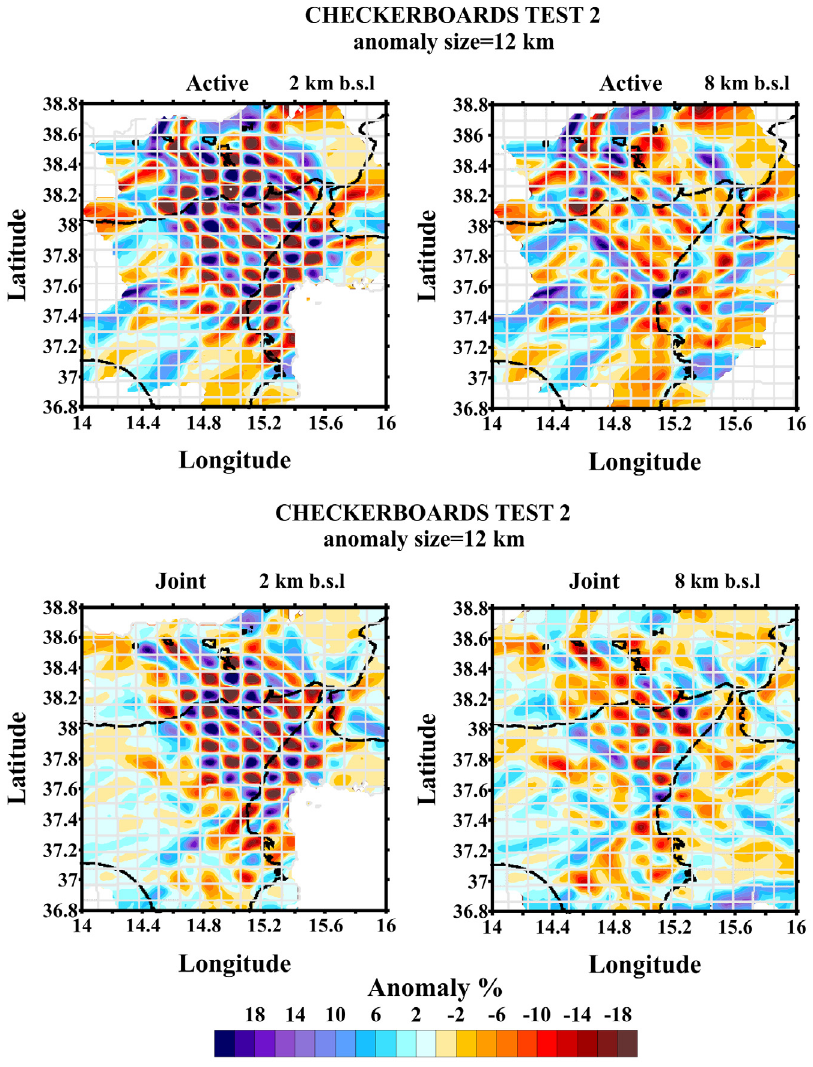
Figure 4. Checkerboard test calculated for the active dataset (upper frame) and the joint dataset (lower frame) using a 12-km synthetic